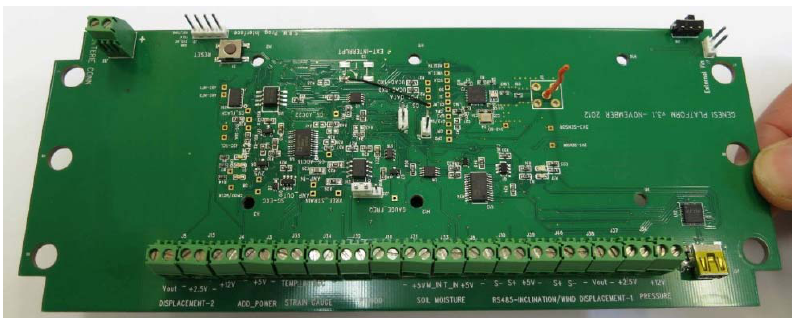
Figure 3. Custom made platform for deployment (I).